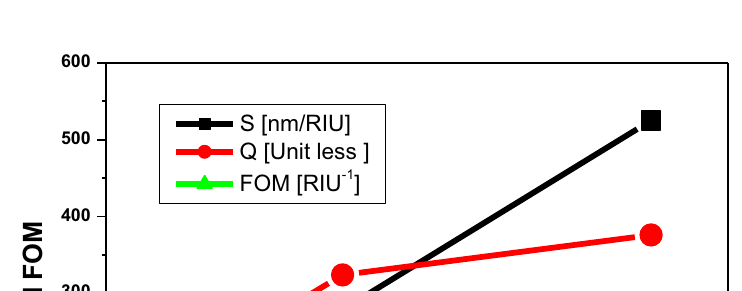
Photonic band gap Figure Figure 7 Figure 9 Figure 10 Table 2. The sensor performance of different structures as shown.